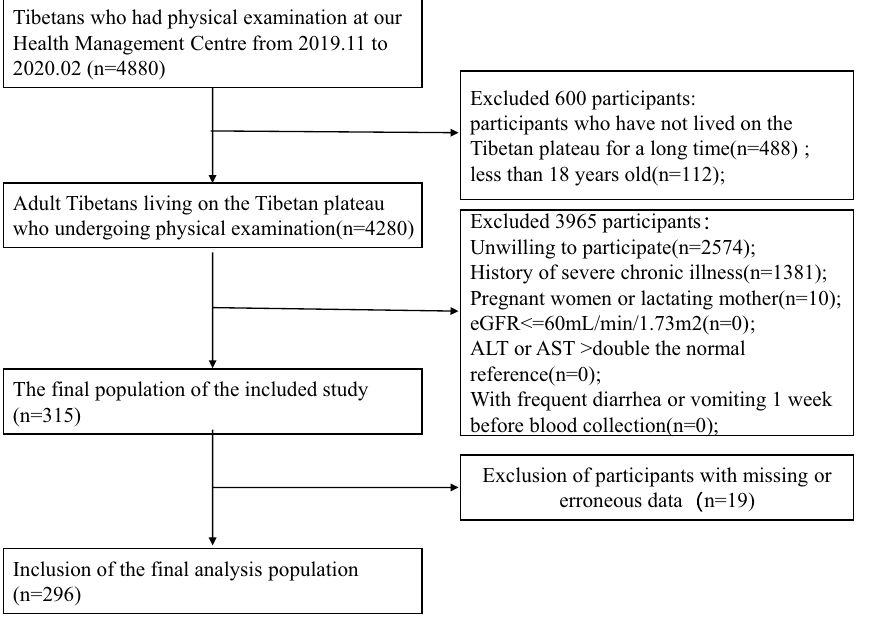
Figure 1. Flowchart of the study. eGFR, estimated glomerular filtration